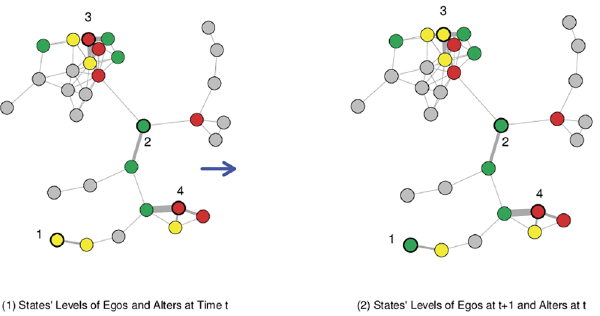
Fig 3. Two consecutive snapshots of 1st to 2nd survey in day 1, with the transient social network. Nodes are participants who filled both surveys. Edge thickness is proportional to contact intensity (IR hits) between surveys. Colors represent state levels (red:low, yellow:medium, green:high) and are shown only for egos 1 – 4 and their alters. The four types of social influence discussed in the text can be seen: ego 1 moved from the neutral level to the high level in the presence of interaction with an alter in the neutral level (push). Ego 2 remained in the high level in correspondence to intense contact with an alter in the high level (inertia). Ego 3 was in the low level and moved to neutral after intense contact with alters in the high level (attraction). Remarkably, the three egos have low scores in their corresponding traits. Ego 4 remained in the low level after contact with an alter in the high level (repulsion). The represented states are creativity for node 1, extraversion for nodes 2 and 4 and agreeableness for node